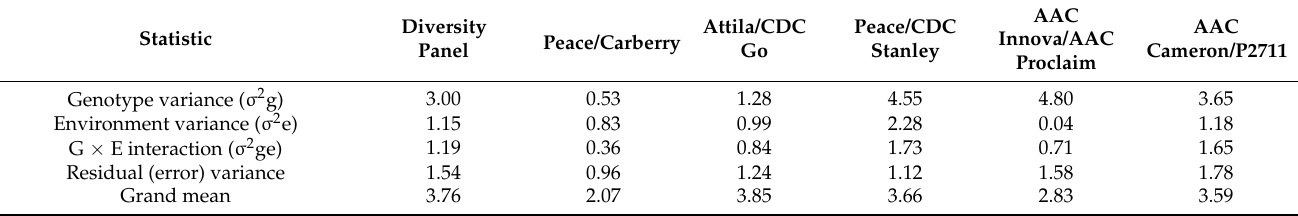
Table 1. Summary statistics of variance component analyses and broad-sense heritability of stripe rust in six spring wheat populations evaluated at three to eight field